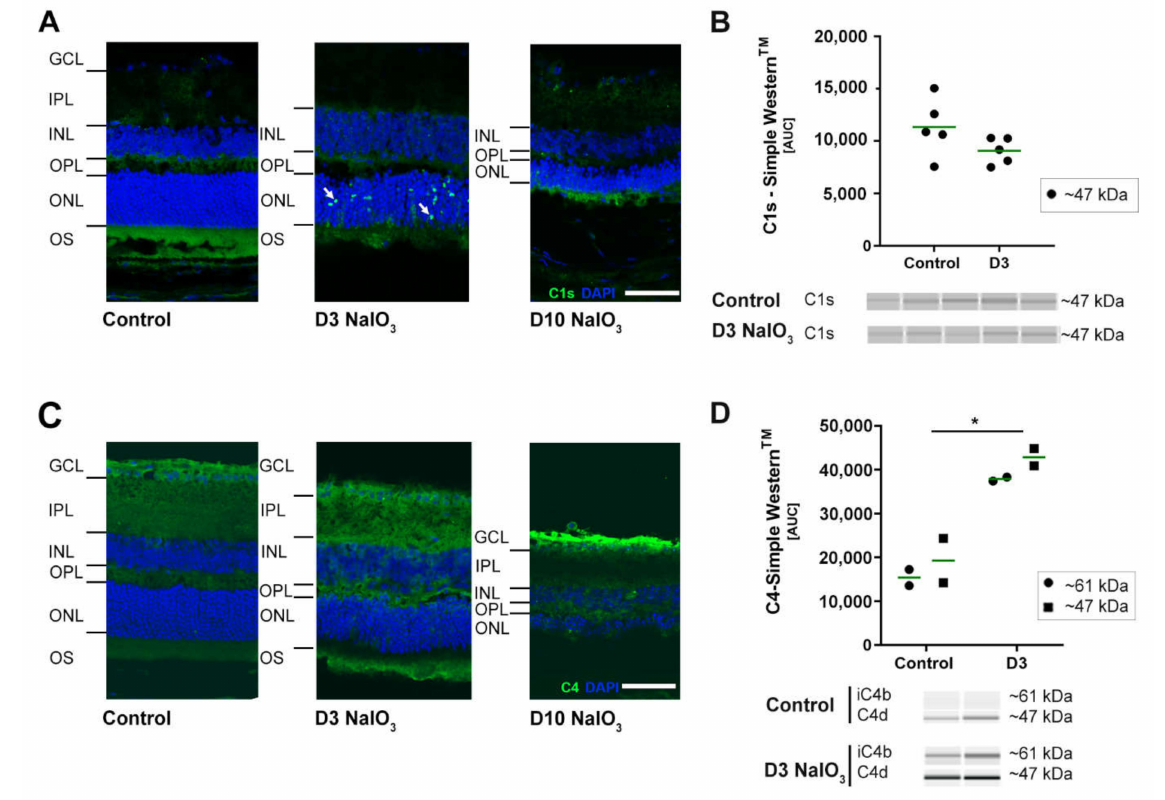
Figure 4. Classical pathway proteins C1s and C4 accumulated in NaIO 3 damaged the retinas. ( A ) C1s immunoreactivity (green) was localised (white arrows) to the ONL at three days after the NaIO 3 treatment. At ten days, no specific C1s staining remained visible. DAPI staining (blue) delineated cell nuclei. ( B ) C1s protein levels were not changed in the Simple Western TM three days after the NaIO 3 treatment. ( C ) C4 (green) was observed in the nerve fibre layer (NFL) ten days following the NaIO 3 treatment. In contrast, no distinct C4 staining was visible at day 3. Scale bar: 50 µ m. ( D ) C4 cleavage products C4d (47 kDa) and iC4b (61 kDa) were increased at day 3 after the NaIO 3 treatment in all samples compared to the untreated control using Simple Western TM technology. ( B , D ) Intensity of the signals was measured using ImageJ software. * 0.01 < p < 0.05 (one-way ANOVA and Tukey’s multiple comparisons test). The full blots are shown in Supplementary Figure